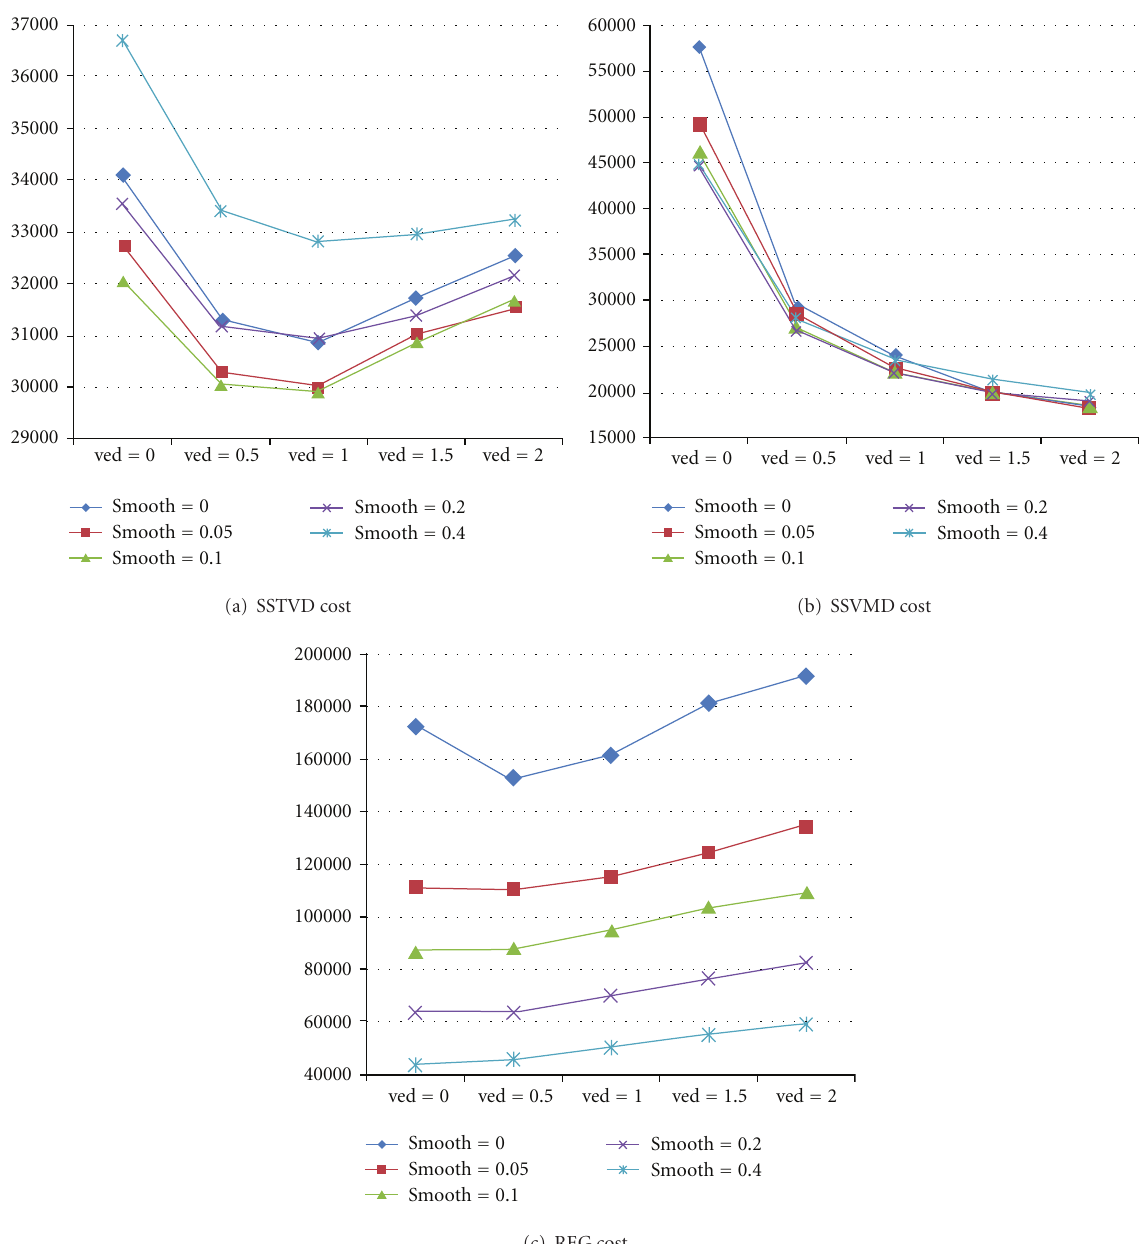
Figure 4: Plots of (a) SSTVD, (b) SSVMD, and (c) REG costs using di ff erent parameter settings. Data are averaged through results from six